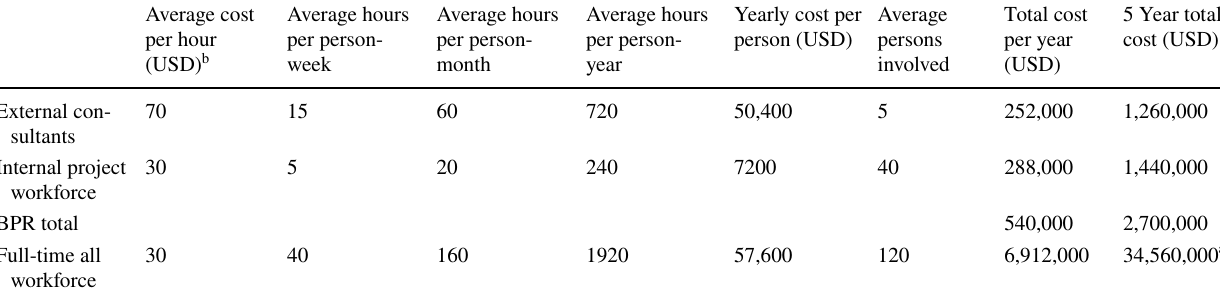
Table 3 Approximated workforce cost and savings in the case of BPR and full IT automation